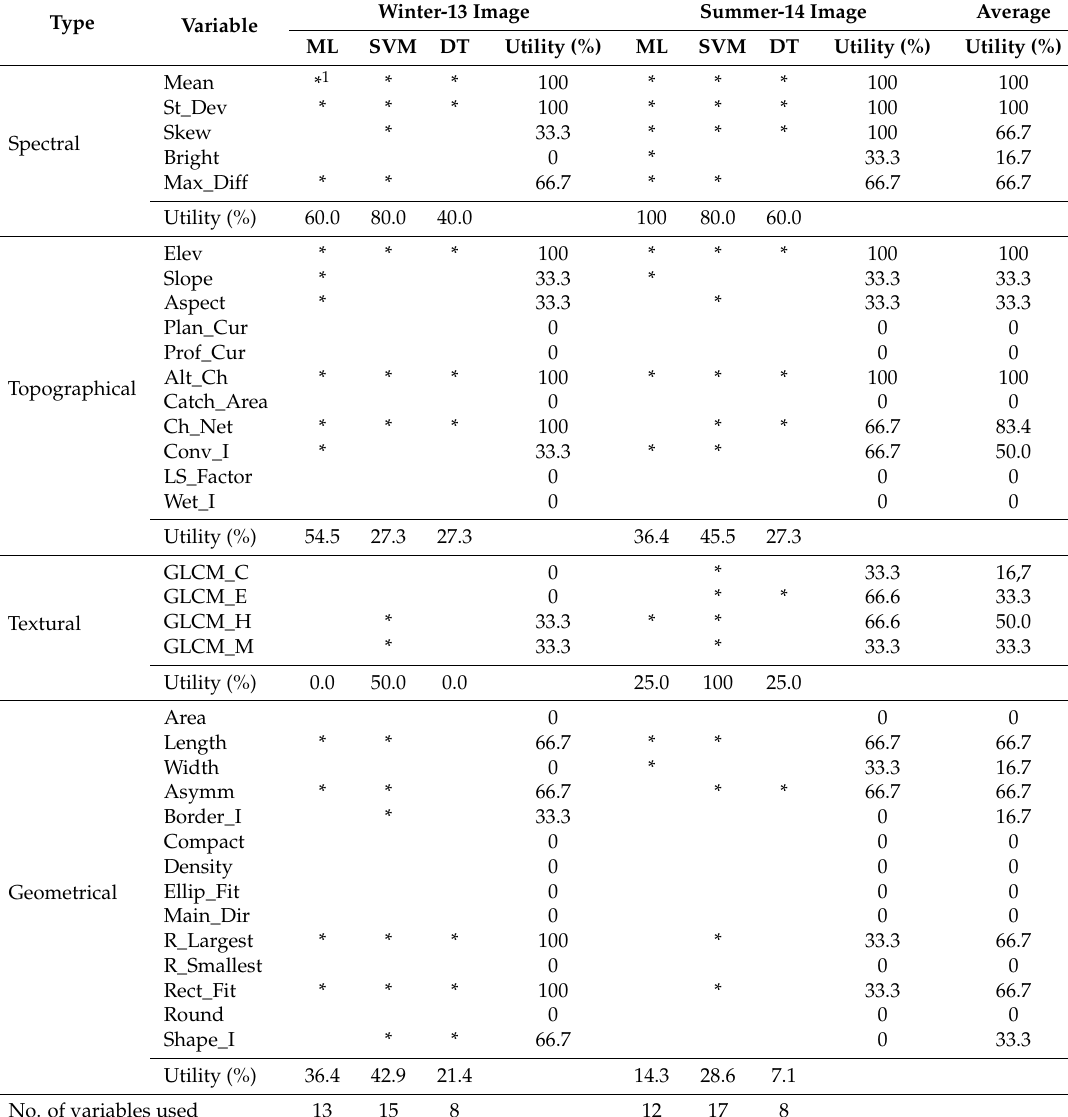
Table 7. Importance of the variables depending on their degree of use with the most accurate combination of object-based and topographical variables in winter and summer images using Maximum Likelihood, Support Vector Machine and Decision Tree